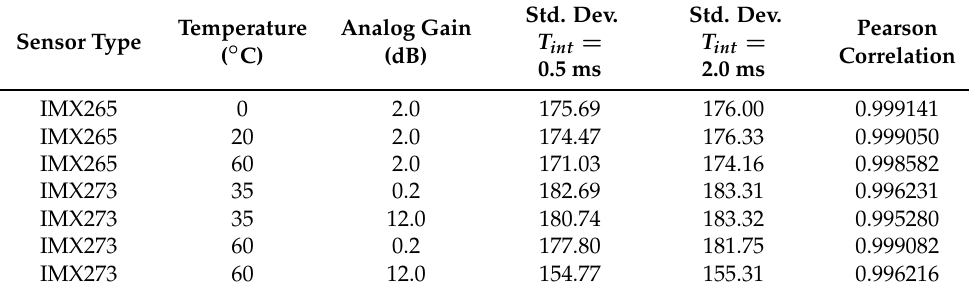
Table 4. PRNU standard deviations and Pearson